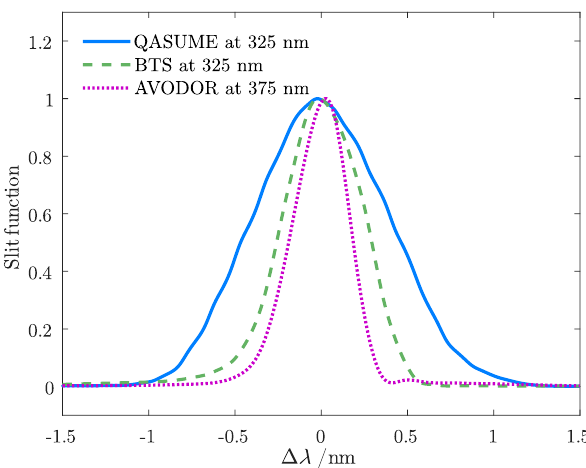
Figure 2. Slit functions measured with narrowband lasers for the spectroradiometers used in the ATMOZ field measurement cam- paign. The laser wavelengths are stated in the